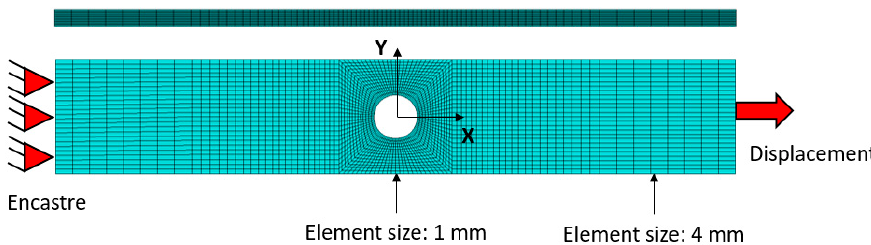
Figure 6. Representation of the finite element model generated considering the test conditions. A high level of discretization was defined at the stress concentration region.